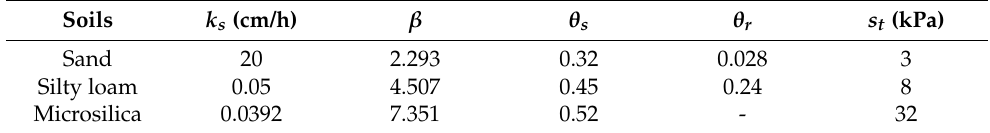
Table 2. Soil properties and parameters.